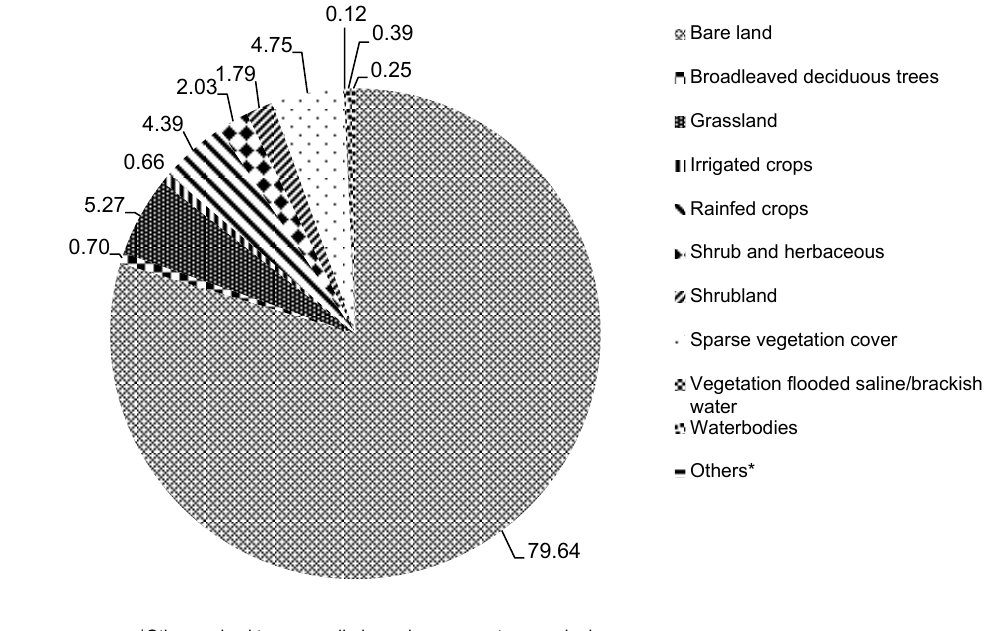
Figure 5. Proportion of main land cover (% total land area) and land use in the NENA region (http://maps.elie.ucl.ac.be/CCI/viewer/index. php; last access: 10 September